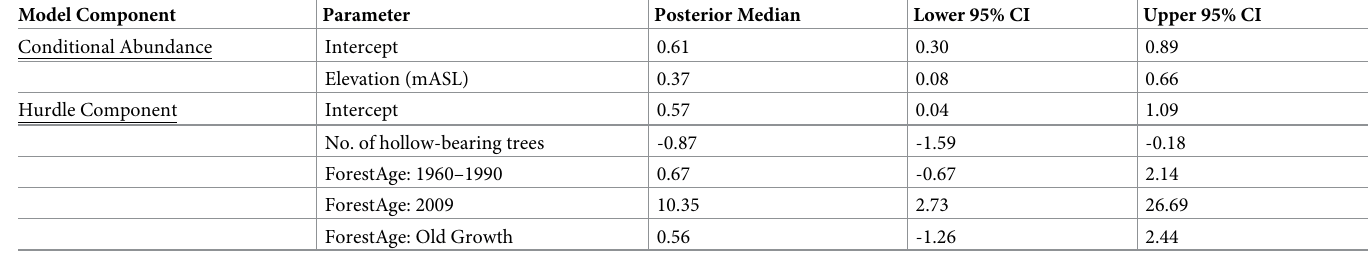
Table 2. The best fitting hurdle model for the presence and conditional abundance of the Southern Greater Glider in Mountain Ash forests of the Central High- lands of Victoria. The hurdle component models the probability of recording zero individuals of the Southern Greater Glider on a site and the conditional component models the number of the Southern Greater Glider recorded given the presence of the species on a site. mASL = metres above sea level. Model